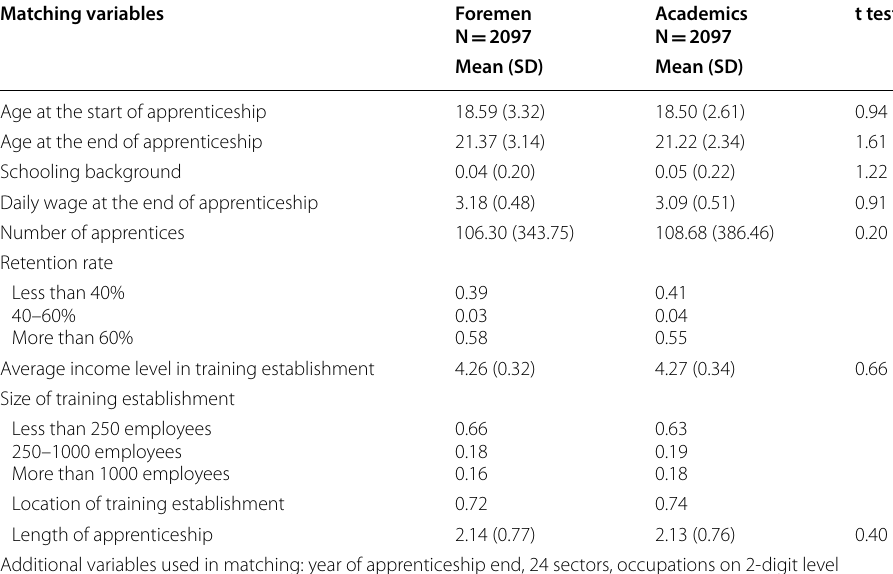
Source: LIAB longitudinal model